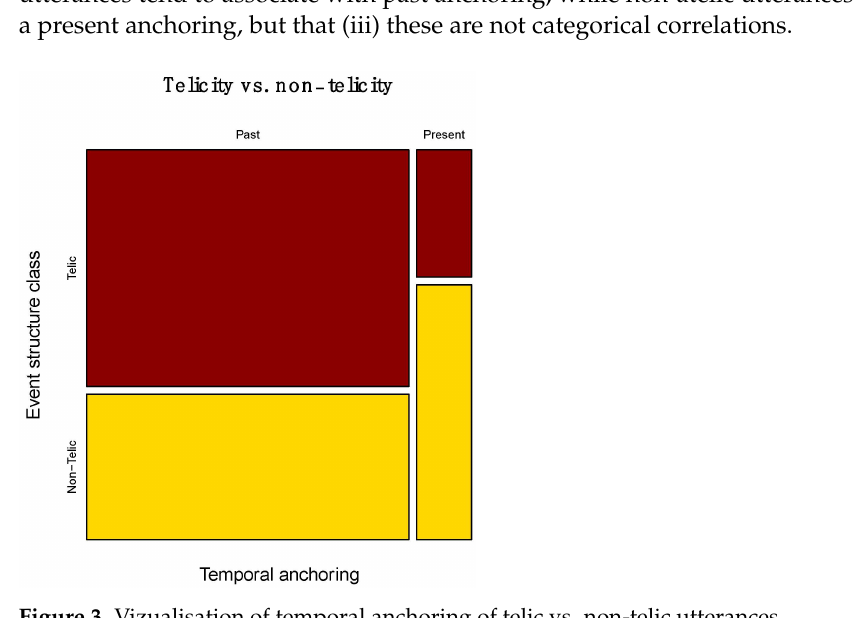
Figure 3. Vizualisation of temporal anchoring of telic vs. non-telic